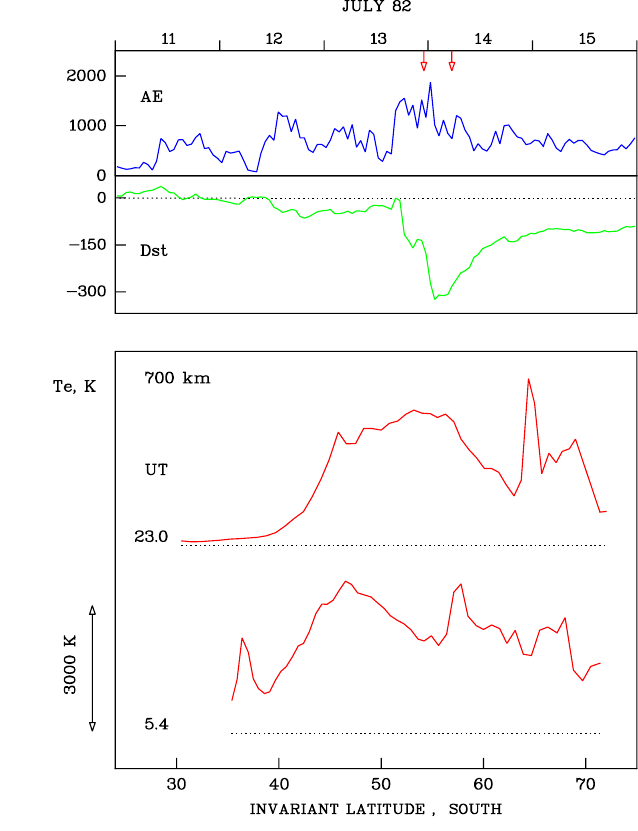
Fig. 16. Largest displacement of the subauroral electron tempera- ture enhancement towards lower latitudes as observed in the DE-2 data set. The format of data presentation corresponds to that of Fig. 15. This time, however, the dotted reference lines mark the 1200K temperature level. Also, a constant temperature gradient of 2.5K/km was used in the height adjustment procedure. Solar and magnetic local time of observation are approximately 03h and 02h, respectively. Both profiles were obtained in the Southern Hemi-